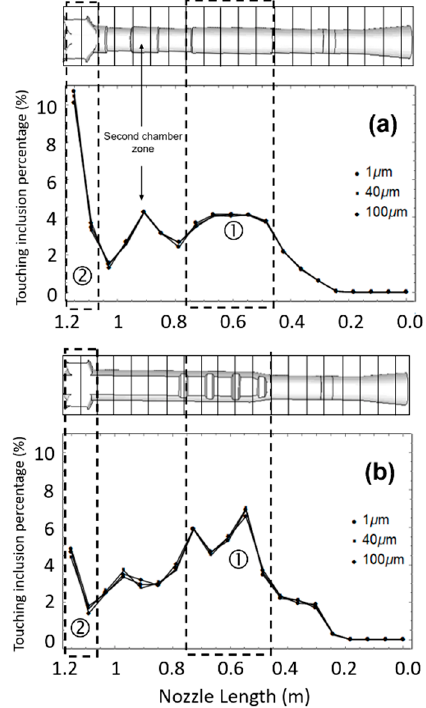
Figure 4. Touching inclusion distribution along both nozzle types for three inclusion sizes: 1 μ m